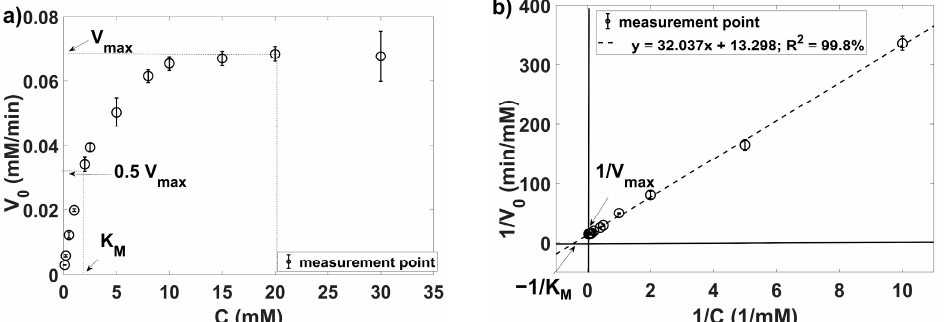
Figure 7. ( a ) Dependence of initial reaction rate ( V 0 ) and urea concentration and ( b ) Lineweaver– Burk plot.